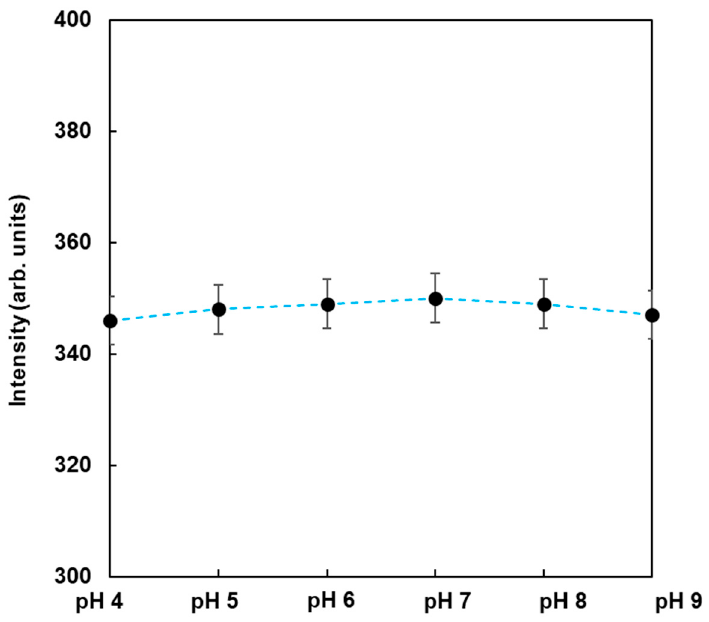
Figure 4. Fluorescence intensities of FMB-Con A in the buffer at different pH values. [FMB-Con A] = 10 μ g/mL; Excitation wavelength, 550 nm.